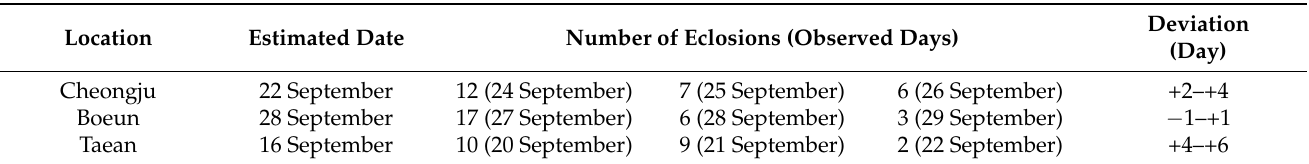
Table 3. Comparison of the calculated and actual data of the adult Spodoptera frugiperda